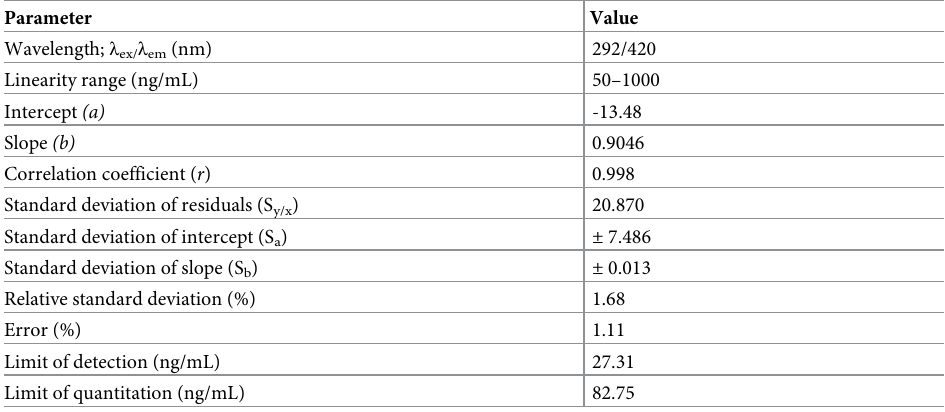
Table 1. Analytical data of the micellar-enhanced spectrofluorimetric method for determination of LAP.